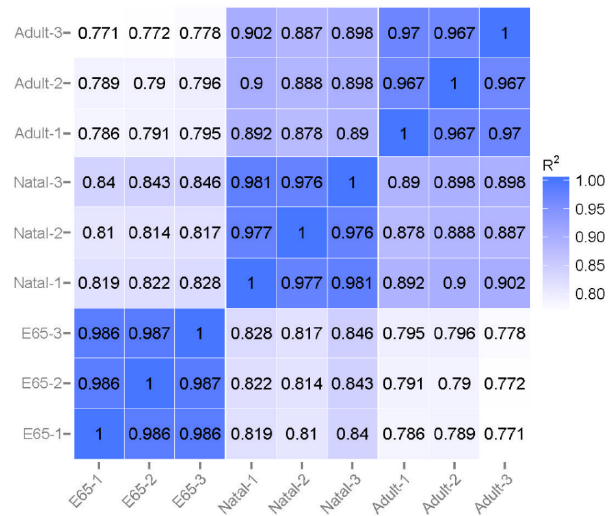
Figure 1. Correlation of gene expression levels among the samples. Pearson correlation coefficients are shown within each cell.